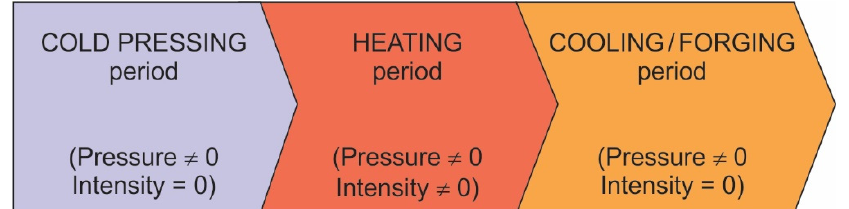
Figure 2. SEM micrograph of the WPL200 Fe powder to be consolidated by MF ‐ ERS.